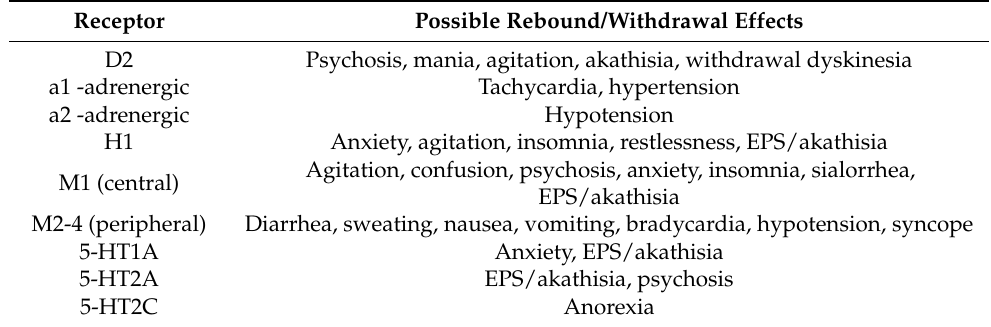
Table 1. Possible rebound symptoms when interrupting an antipsychotic